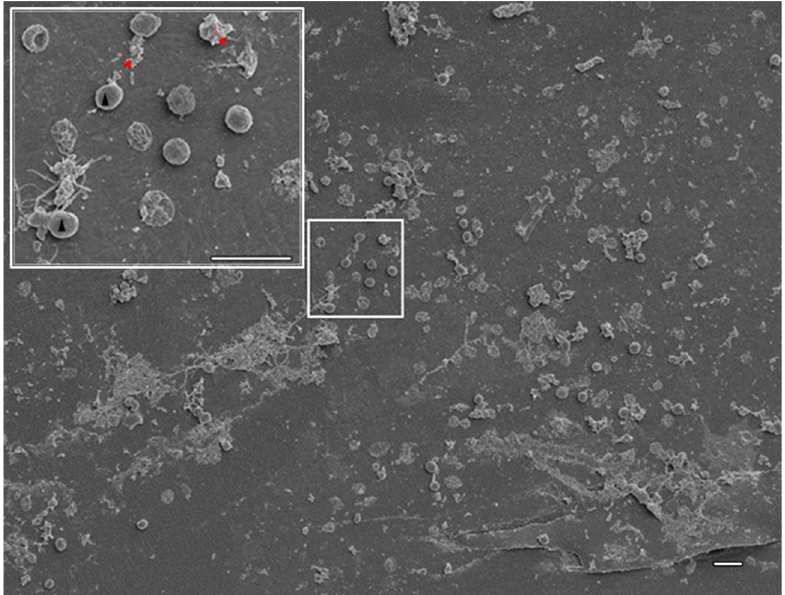
Figure 2. Central venous catheter colonization. Representative scanning electron micrograph of the lumen of a CVC removed from a patient with a catheter-related bloodstream infection. Rod-shaped bacteria (red arrows) and fungi (black arrow heads) colonized the CVC coexisting with host factors such as red blood cells, as can be observed with more detail in the inset. Scale bar: 10 µ